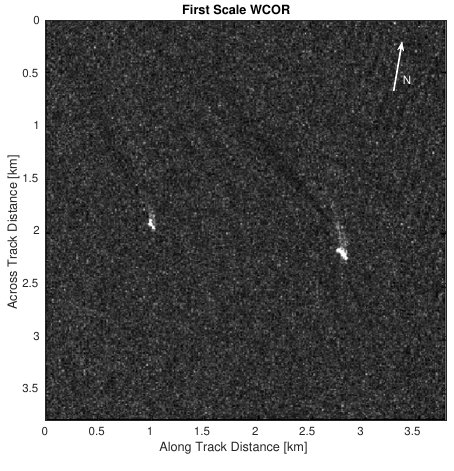
Figure 13. First scale WCOR.